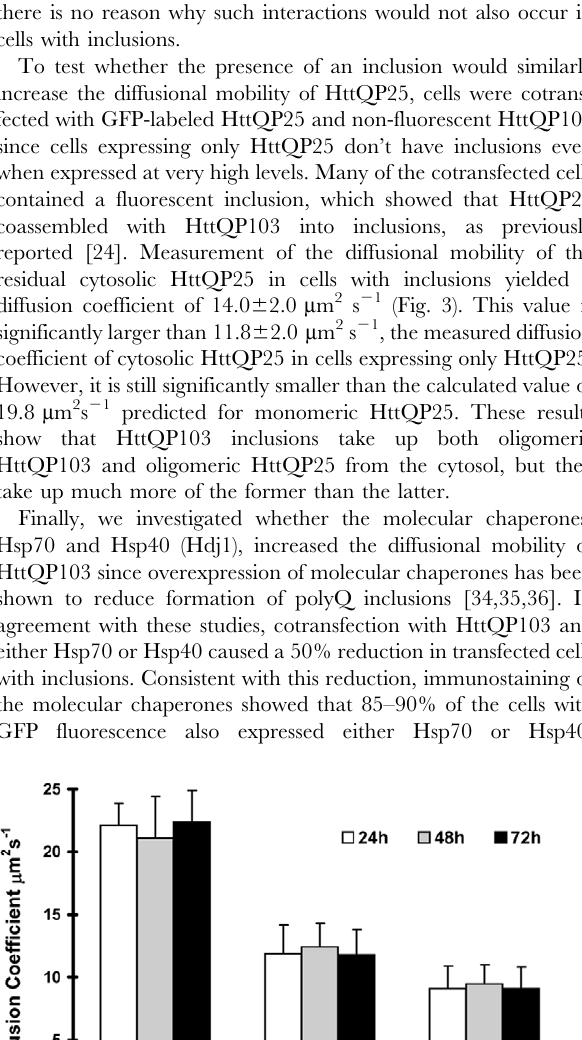
Figure 1. Diffusional mobility of Htt fragments in Sn56 cells. In A, the autocorrelation curves for cytosolic GFP, HttQP25, HttQP47, and HttQP103 were measured 72h after transfection. In cells expressing HttQP47 and HttQP103, the diffusional mobility was measured in cells without inclusions. Curves were normalized using the Confocor2 program. In B, the residuals for each of the autocorrelation curves shown in A. In C, diffusion coefficients of GFP, HttQP25, HttQP47, and HttQP103 were measured 72h after transfection. The diffusion coefficients and standard deviations were calculated by averaging a minimum of 4 data sets each obtained from a different transfection with each data set consisting of a minimum of 10 cells. **, p , 0.005 determined by Student’s t -test of significant difference between GFP and HttQPs diffusion coefficient.